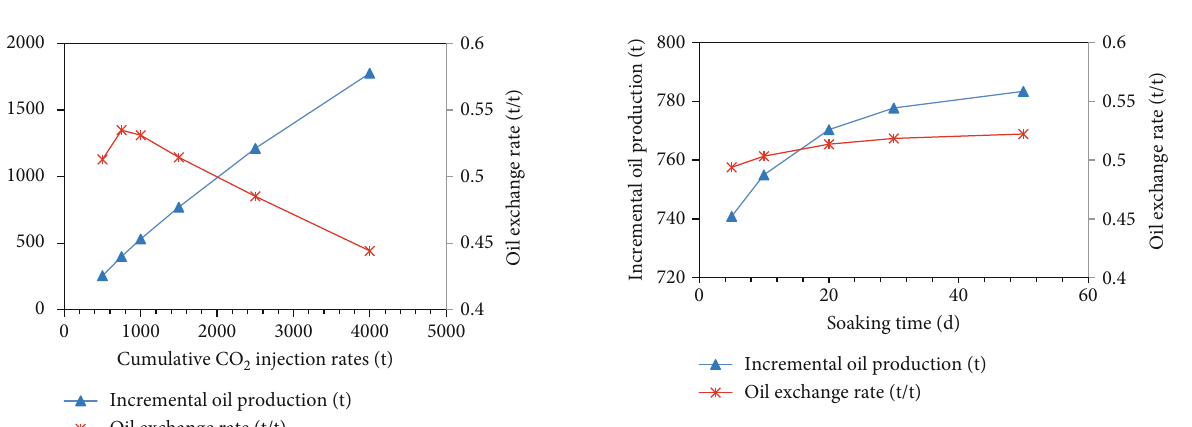
Figure 17: Incremental oil production and oil exchange rate through CO hu ff -n-pu ff under di ff erent soaking times. 2 injection 2